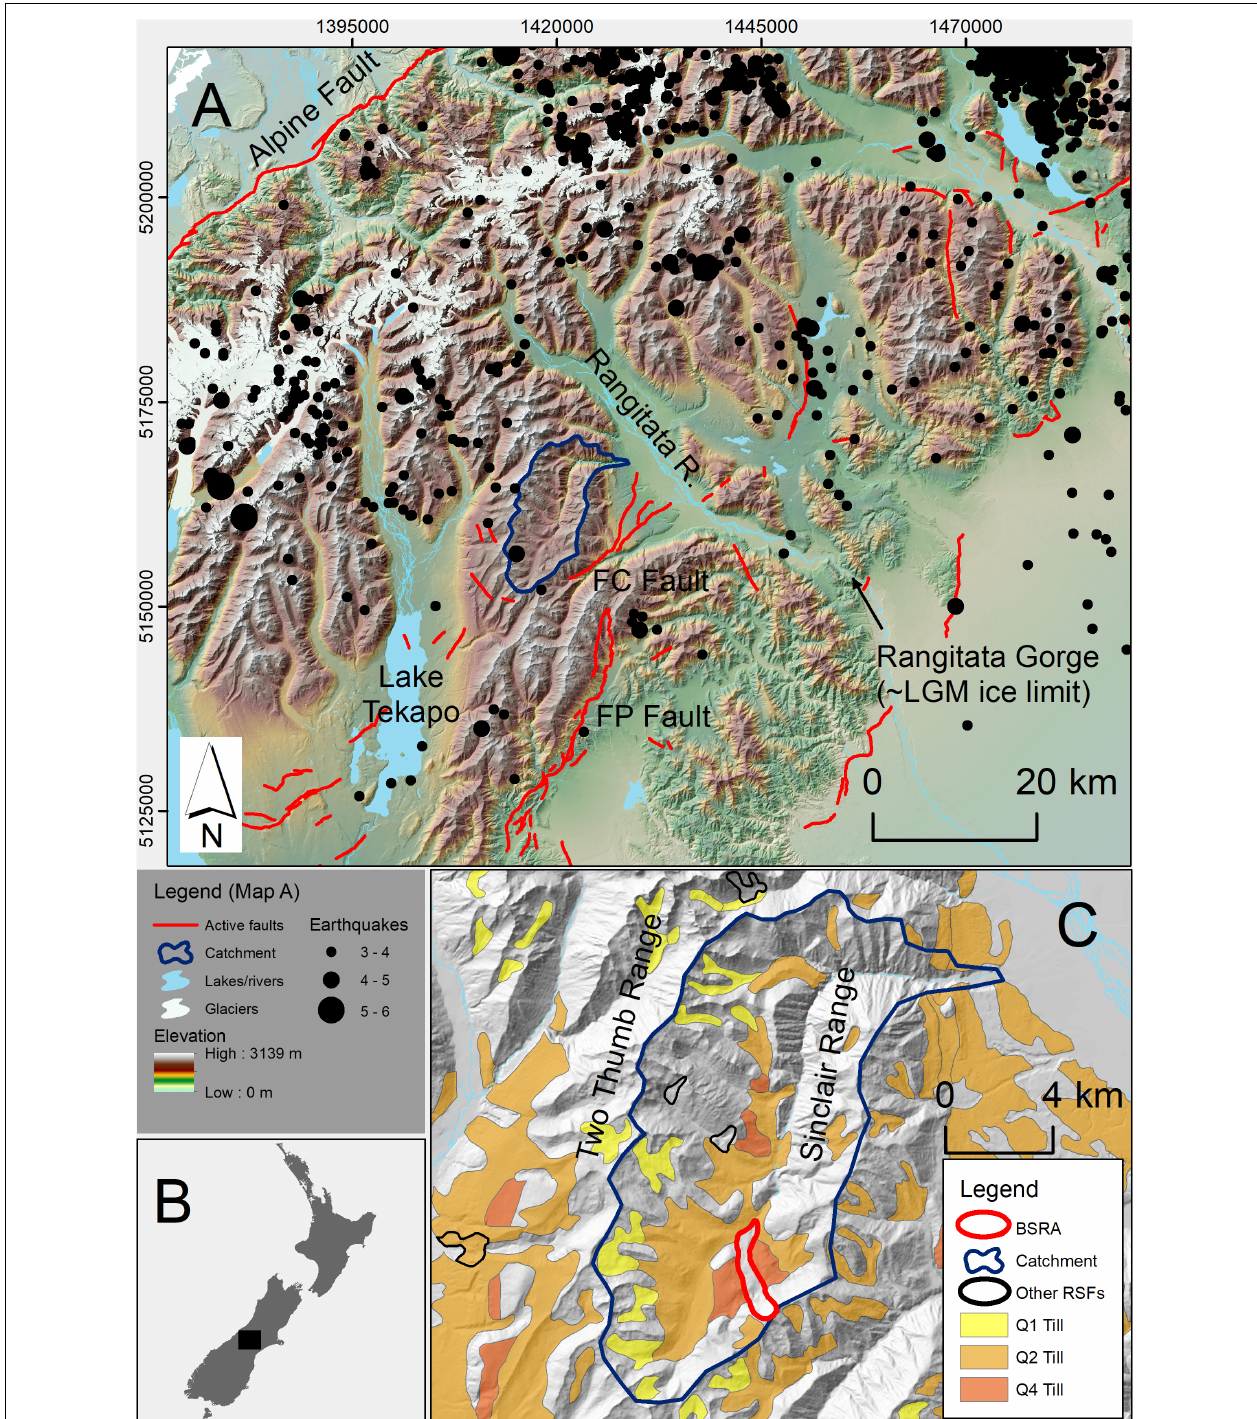
FIGURE 1 | (A) Location of Bush Stream catchment (blue outline), a tributary of the Rangitata River, within the eastern Southern Alps of New Zealand. Identified active faults are shown in red, sourced from the Institute of Geological and Nuclear Sciences (GNS Science) active faults database; http://data.gns.cri.nz/af/. The Alpine Fault, Forest Creek (FC) Fault, and Fox Peak (FP) Fault are labeled. The location of earthquakes ( > M3) within the past 30 years (1990–2020) are shown from the GeoNet Earthquake Catalog, with indicated magnitude; the method of magnitude estimate varies in the catalog. The extant glaciers are shown in white. The approximate LGM extent of the Rangitata Glacier was at the Rangitata Gorge (labeled on map). The topographic data (colored hillshade model) are from LINZ: https://data.linz.govt.nz/. (B) Map of New Zealand with the location of Map A shown by the black rectangle. (C) Map showing the general topography of the Bush Stream catchment [same blue polygon as in Map (A) ] with the Bush Stream Rock Avalanche (red polygon) and other landslides in the area (black polygons), along with the location of glacial sediments (till gravels) as mapped by Cox and Barrell (2007).